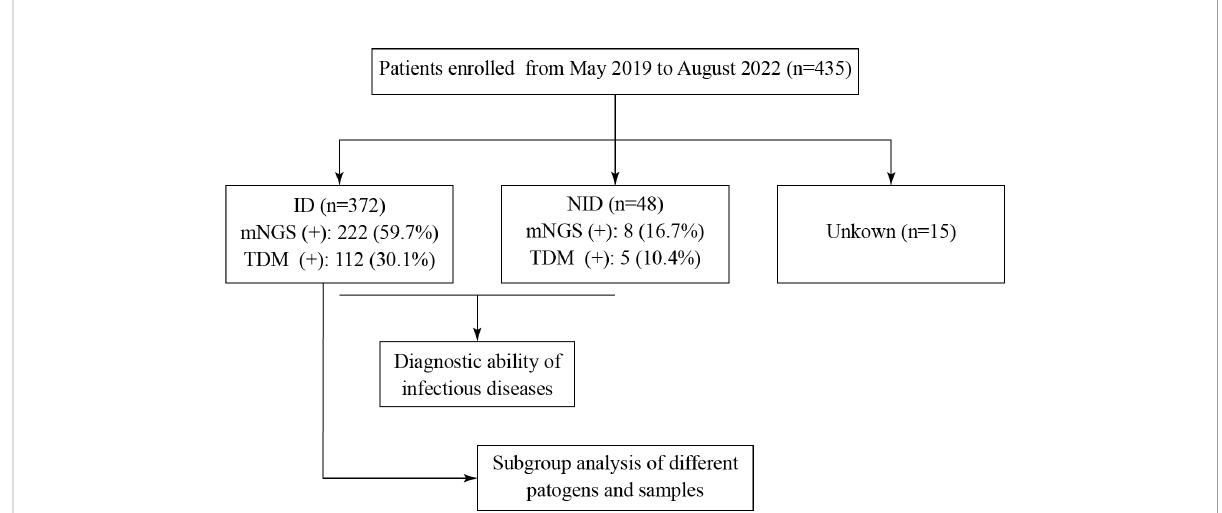
FIGURE 1 Flowchart of this study. A total of 435 patients were enrolled and divided into the ID, NID, and unknown groups. ID and NID patients were used to evaluate the diagnostic ability of mNGS and TDM to detect infection. ID, infectious disease; NID, non-infectious disease; mNGS, metagenomic next-generation sequencing; TDM, traditional diagnostic method.